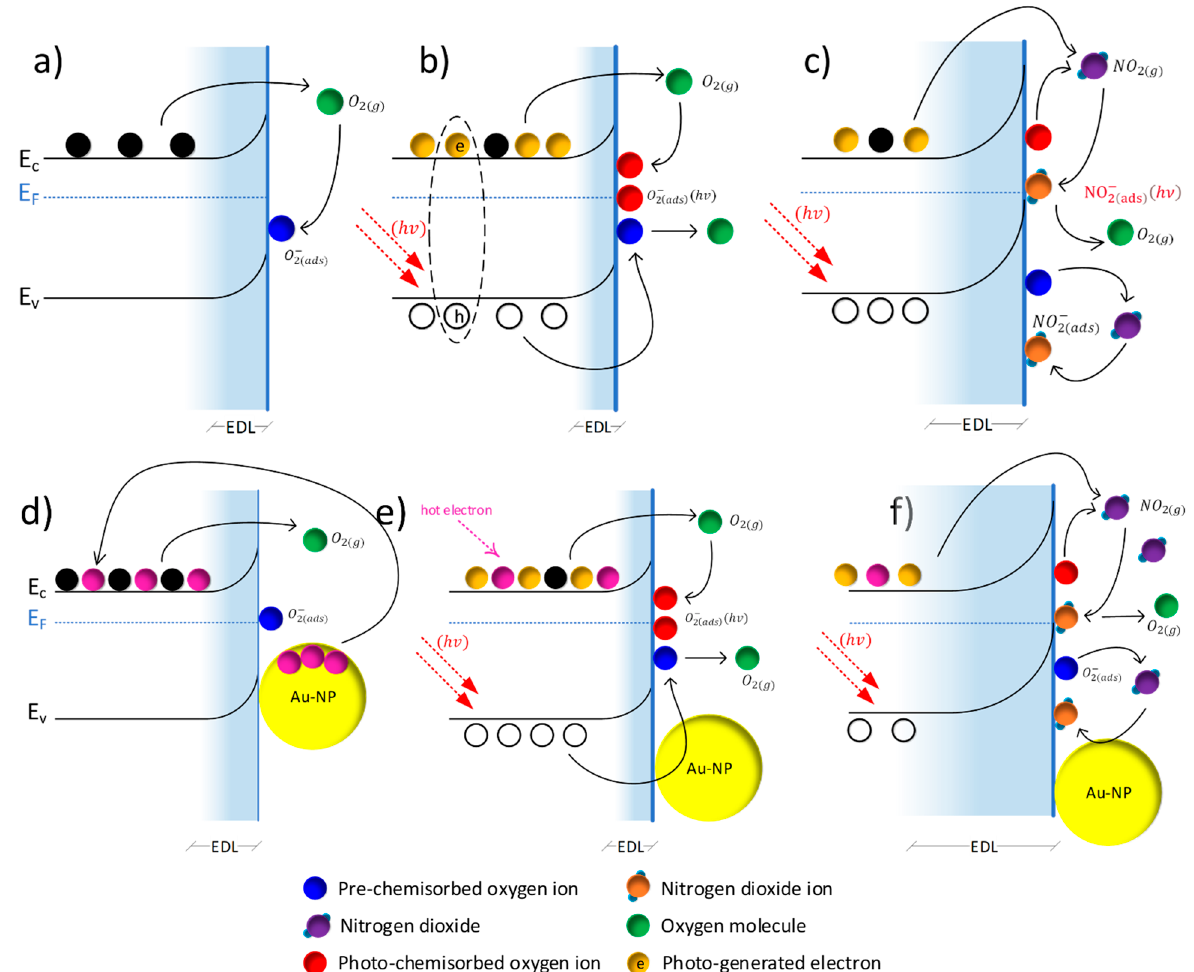
Figure 11. Schematic of electron transfer in energy band diagram of ZnO NRs when detecting NO 2 showing the effect of Au NP decoration. ( a – c ) The mechanism for bare ZnO NRs: ( a ) pre-chemisorbed oxygen ions are formed at RT in dark conditions, ( b ) under visible light illumination, and ( c ) during exposure to NO 2 molecules. ( d – f ) The mechanism for Au NP-decorated ZnO NRs: ( d ) More electrons are formed in conduction band by transferring them from Au NPs, ( e ) under visible light illumination, and ( f ) during exposure to NO 2 molecules.